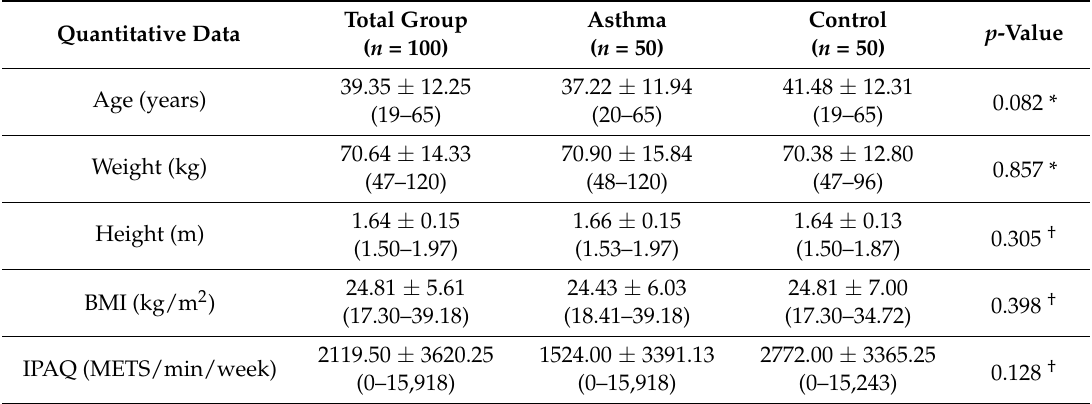
Table 1. Quantitative sociodemographic and descriptive data for patients diagnosed with asthma, healthy matched-paired controls and total sample.